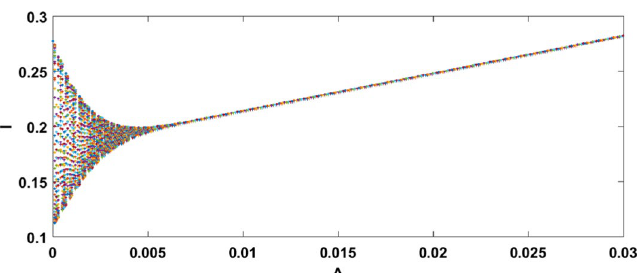
Fig. 7 A bifurcation diagram for the infected population (I) with respect to the parameter A